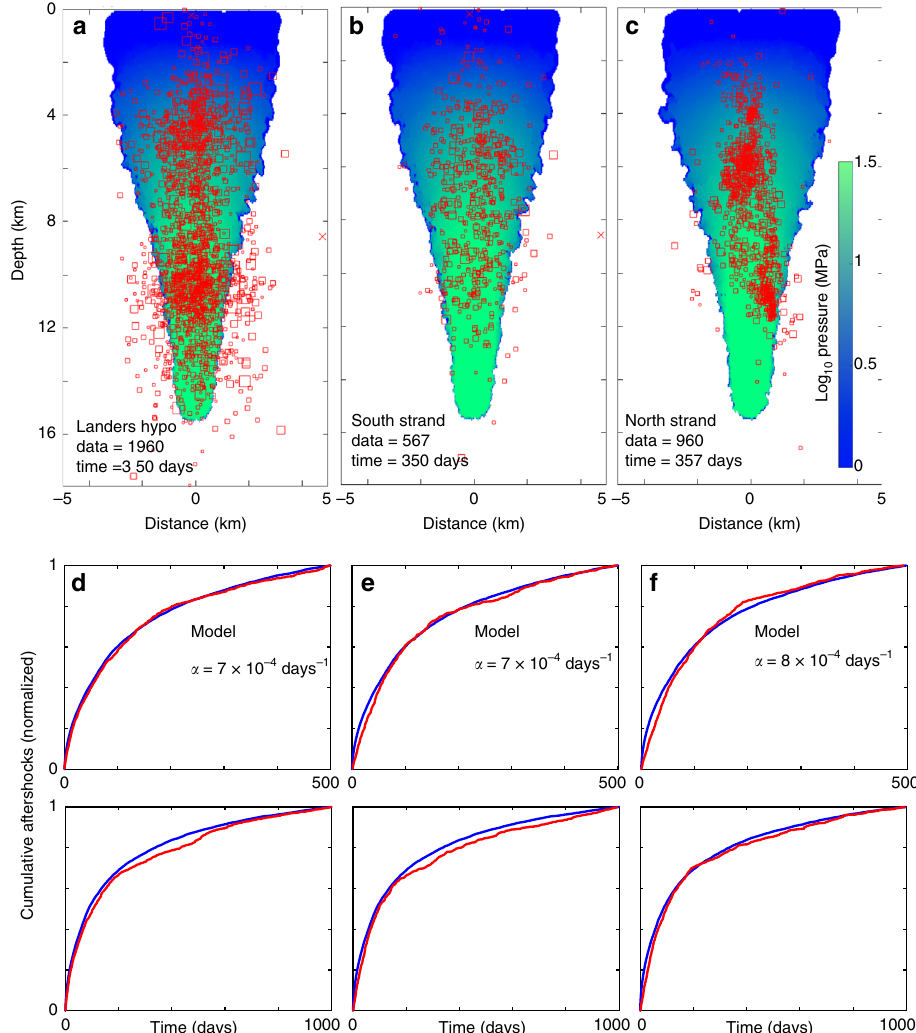
Fig. 5 Model results from Landers Hypo, the South Strand, and the North strand. ( a – c ) Comparison of computed pressure fi elds with “ data = ” measured hypocenters for three different dilatant sections of the Landers earthquake. ( d – f , e ) Comparison of data (red) and model results (blue) for two different time windows, showing that despite dramatic differences in productivity, all three sections exhibit very similar permeability recovery times. See Supplementary Fig. 5 for the corresponding Omori fi